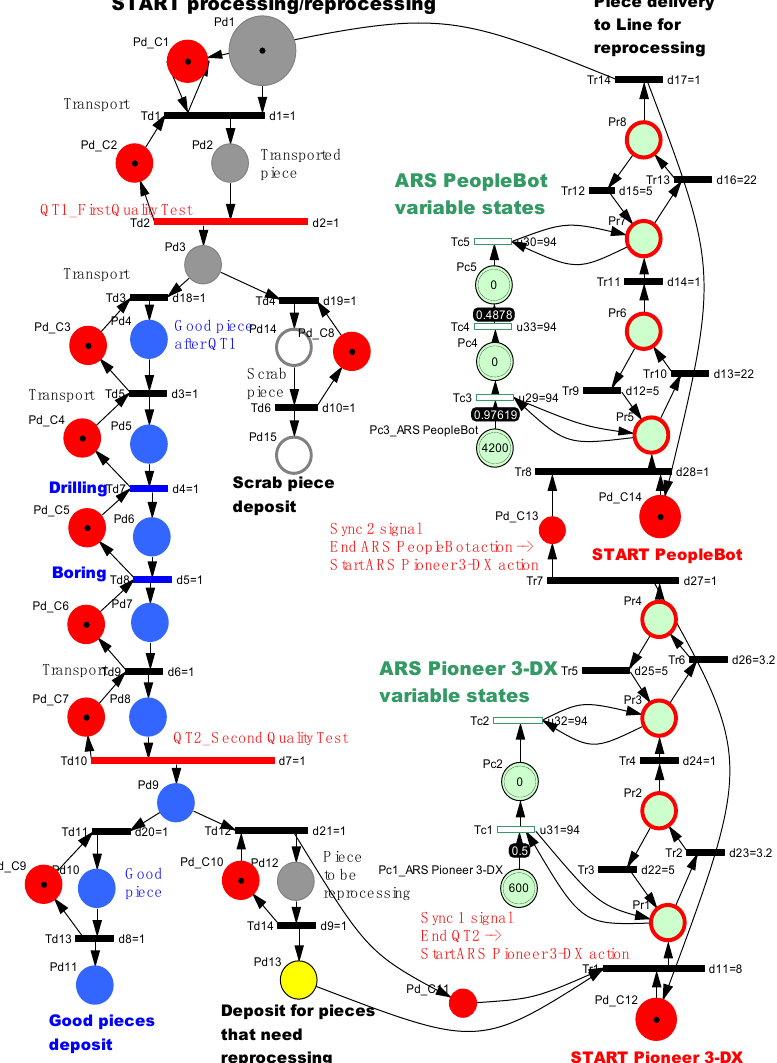
Figure 6. SHPN model of P/RML assisted by ARSs.